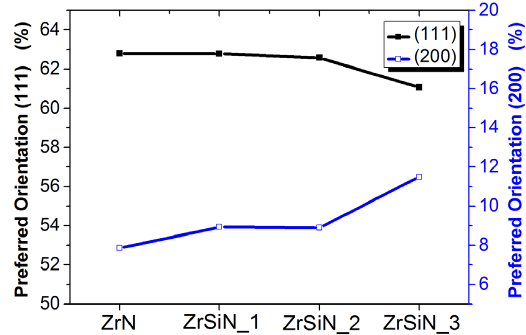
Figure 3. Preferred orientation obtained from GAXRD 1° – I(200)/I(111) ratio is higher as Si content is increased.